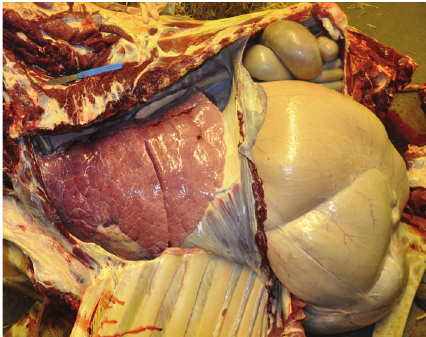
Figure 5: The initial postmortem examination approach consisted of removing the overlying abdominal and thoracic walls to validate the organ positions seen on laparoscopy. Note the wide flat ribs that may be thoracoscopy di ffi cult by severely limiting the ability to manipulate the